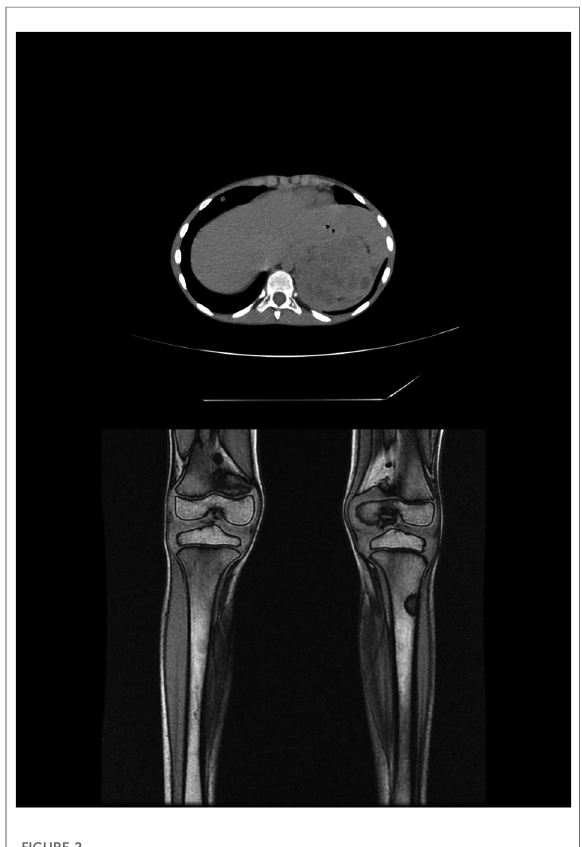
FIGURE 2 Patient No. 3 ’ s MRI images. MRI, magnetic resonance